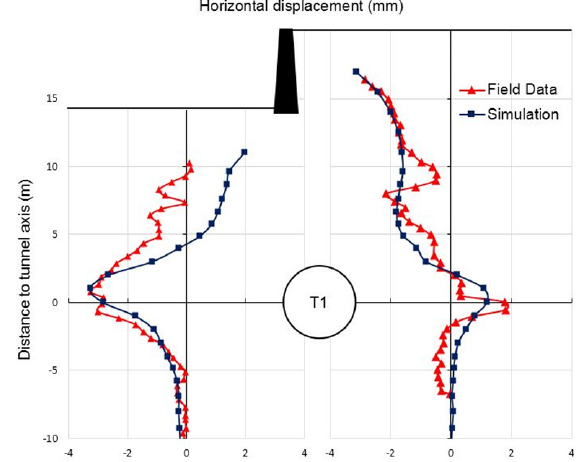
Figure 16: Final lateral